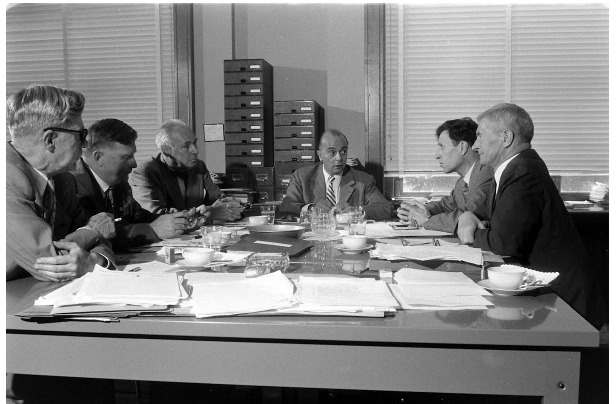
Figure 3. 1957 meeting of the IGY Special Committee Bureau in Brussels. From left to right, Vladimir V. Belousov (Vice-President, USSR), Lloyd Berkner (Vice-President, USA), Marcel Nicolet (Secretary General, Belgium), Jean Coulomb (member, France), and Sydney Chapman (President, UK) (Rodnikov et al.,